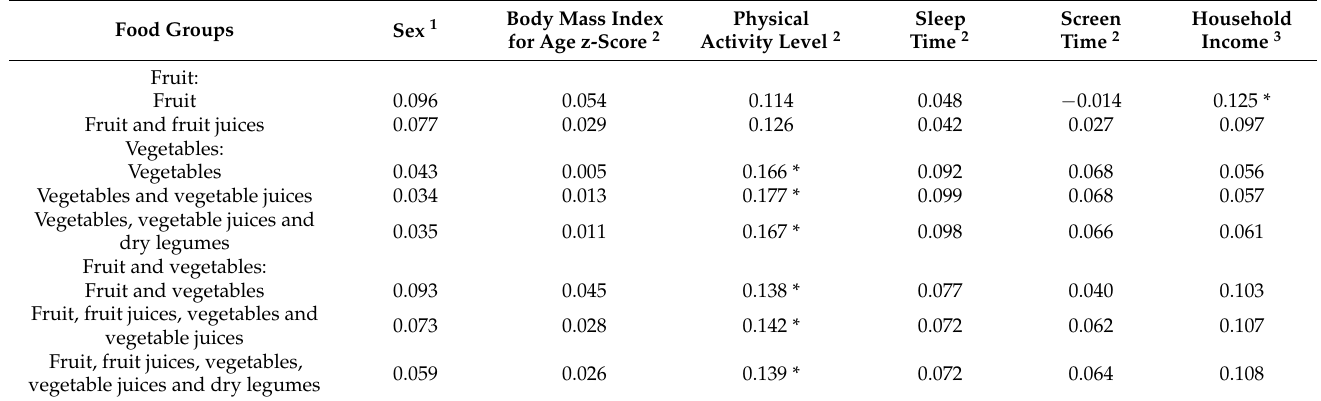
Table 2. Correlation between children’s characteristics and fruit and vegetable food groups intake at baseline (n =